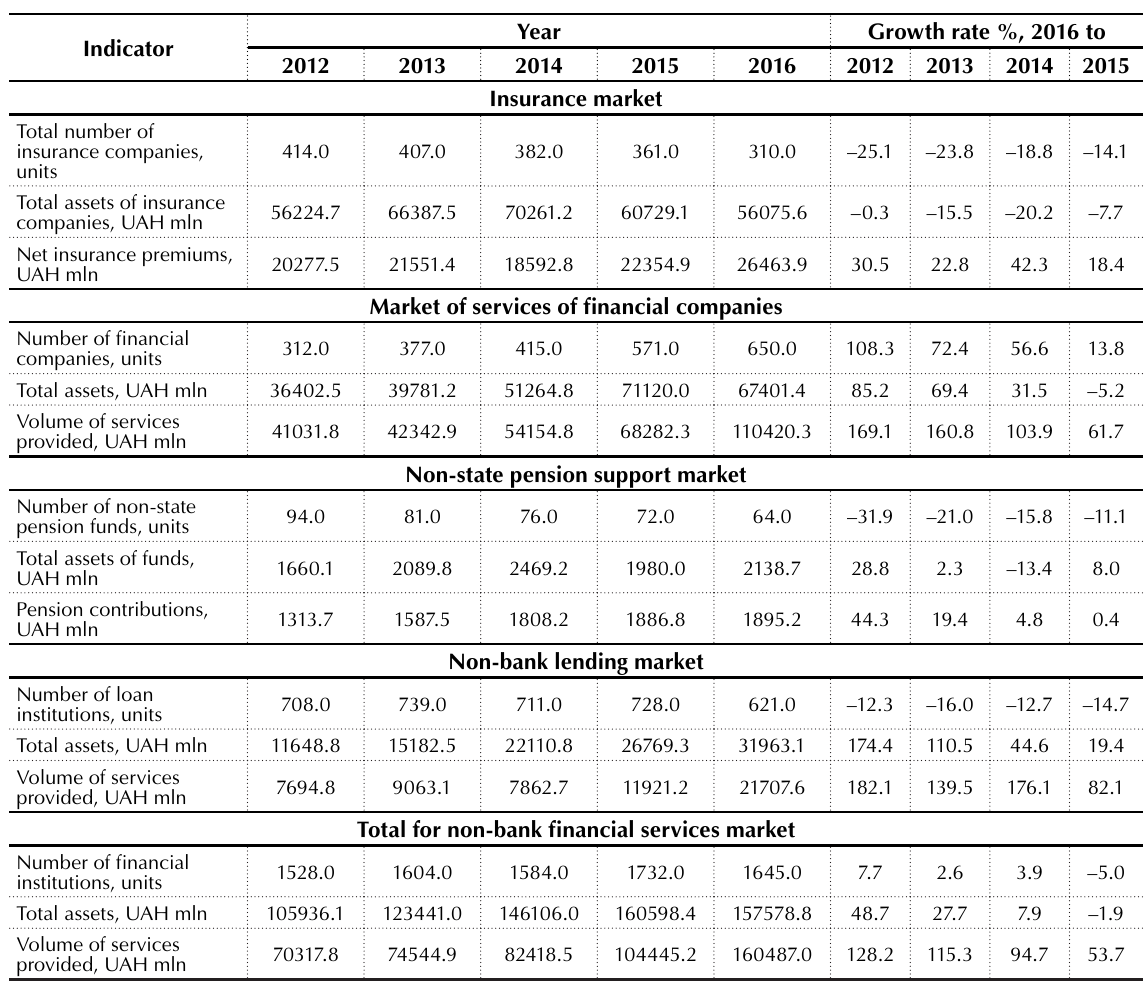
Table 4. Dynamics of main indicators of Ukrainian FSM development for